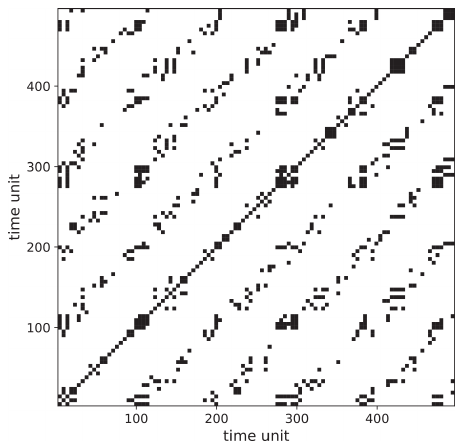
Figure 11. RP of the Poisson process with periodical forcing (Fig. 7c) using mED showing the aliasing effect due to improper window size (note that this effect also occurs for the standard ED